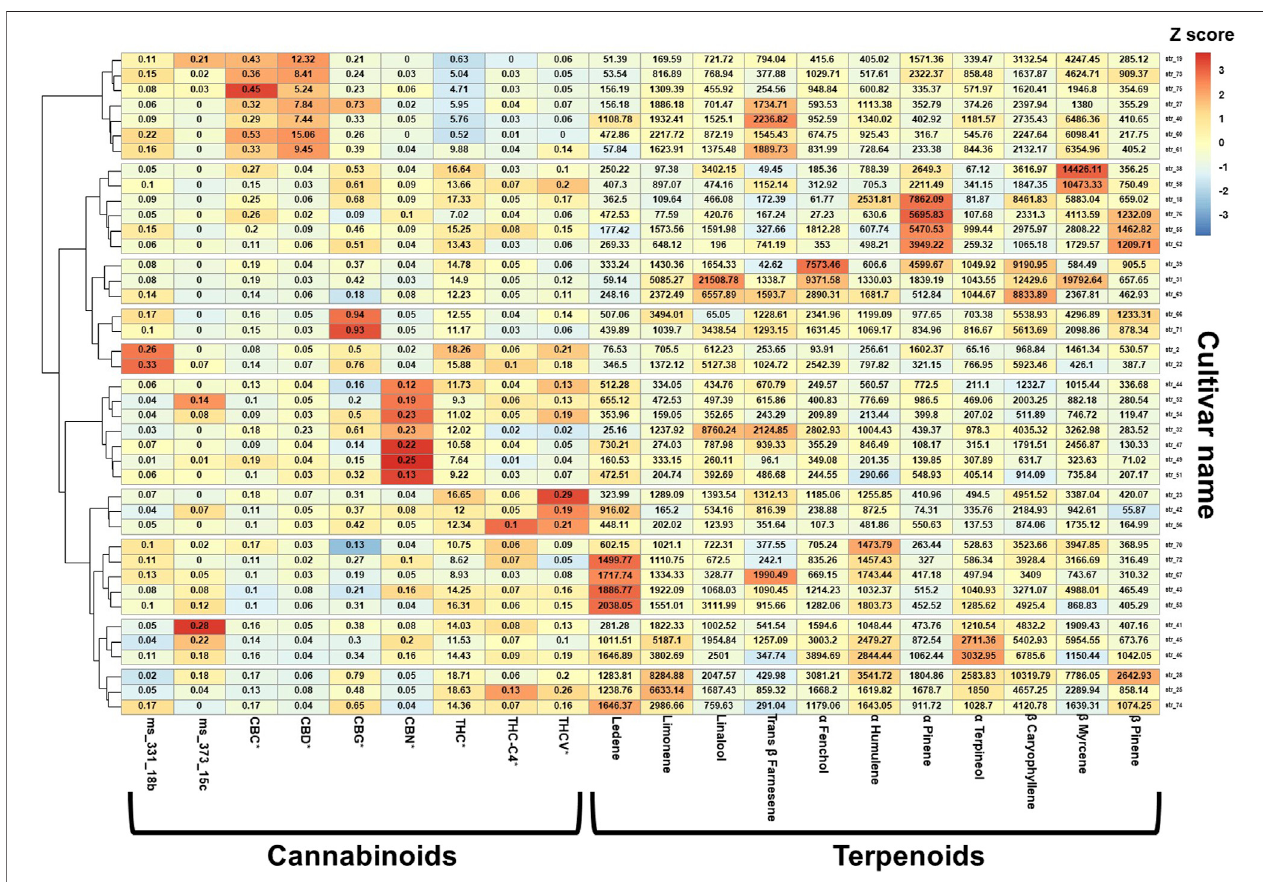
FIGURE 3 | Cannabinoids and terpenoids relative dose in the consumed cultivars. The values in each box are the absolute concentrations of the speci fi c phytocannabinoid (%w/w)orterpenoid (ppm)withineachcultivar,andthecolorscalerepresentsthez-scaled phytocannabinoidandterpenoid concentrationvariations betweencultivars.*Foreachphytocannabinoid,theconcentrationsoftheacidanditsneutralcounterpartweresummedandreportedasthetotalcontent;Methodused: package "pheatmap", function pheatmap, with the (default): distance measure used in clustering rows "euclidean", clustering method used is "complete" on z scored data scaled by row; THC (-)- Δ 9-trans-tetrahydrocannabinol; CBD, cannabidiol; CBC, cannabichromene; CBG, cannabigerol; CBN, cannabinol; THC-C4 (-)- Δ 9- trans-tetrahydrocannabinol-C4; THCV (-)- Δ